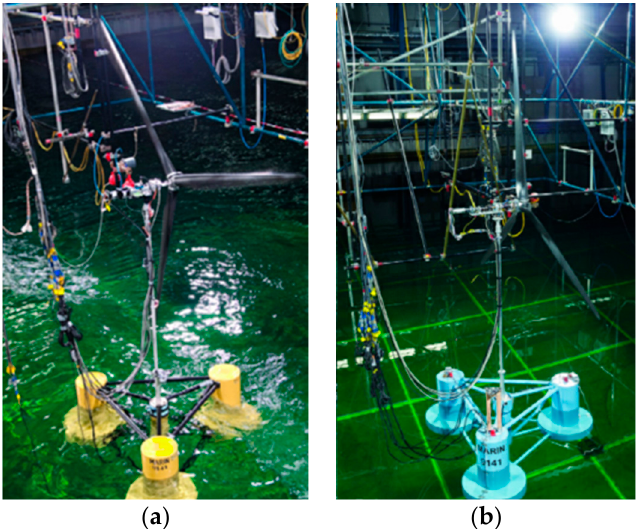
Figure 5. DeepCWind project (Reprinted/adapted with permission from Ref. [56]. 2014, Goupee, A.J.); ( a ) DeepCWind project in 2011; ( b ) DeepCWind project in